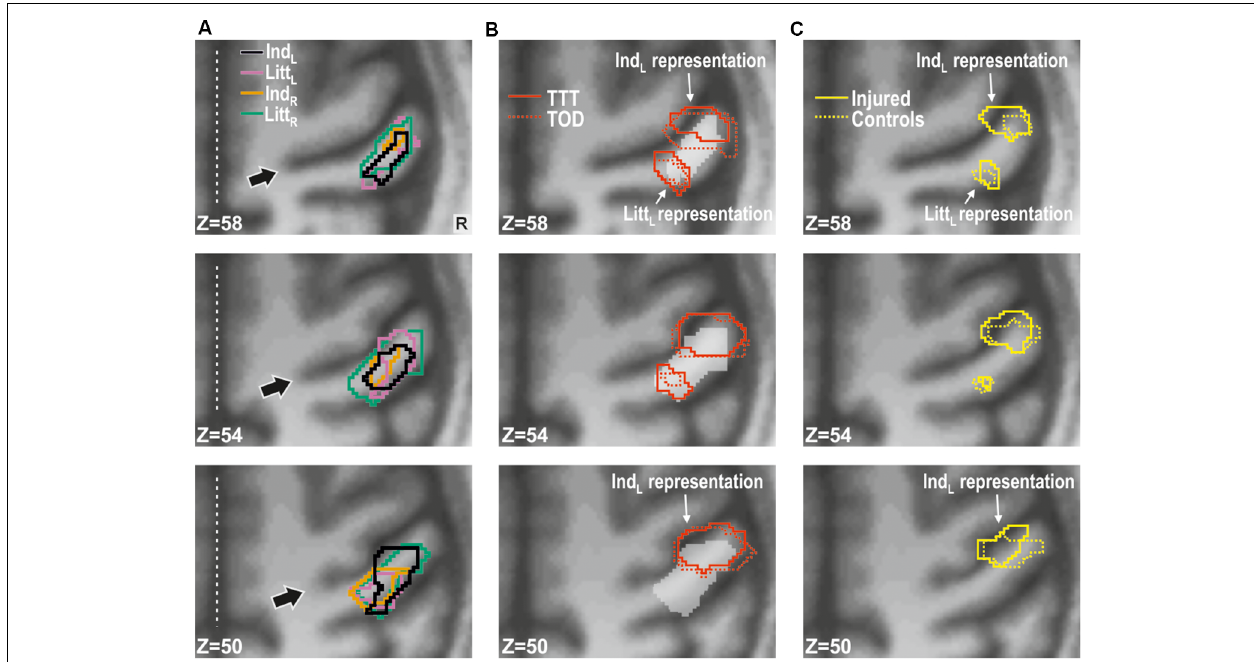
FIGURE 3 | Effect of injury in contralesional S1. (A) Main effect of injury obtained with stimulation of each of the fingers shown on transaxial slices of the averaged brain calculated across montreal neurological institute (MNI)-normalized participant-specific T1-weighted images. Lines enclose areas with stronger BOLD activity for the nerve-injured ( n = 11) compared to the control participants ( n = 11) and the color of the lines indicate stimulated finger: left index (Ind L ), left little (Litt L ), right index (Ind R ) and right little (Litt R ) finger. Arrows indicate central sulcus and dotted white lines the interhemispheric fissure. R, right. (B) Index finger (Ind L ) and little finger (Litt L ) representations outlined based on data from the tactile threshold-tracking task (TTT, red solid lines) and the tactile oddball-detection task (TOD, red dashed lines) performed by all study participants. The white semi-transparent zone represents the envelope of areas with main effects of injury as shown in panel (A) . (C) Index and little finger representations outlined for injured (yellow solid lines) and control participants (yellow dashed lines) based on the main effect of a finger in ANOVAs separately applied to data from each of the two groups and with finger and task as factors. (B,C) Same general format as in panel (A) .